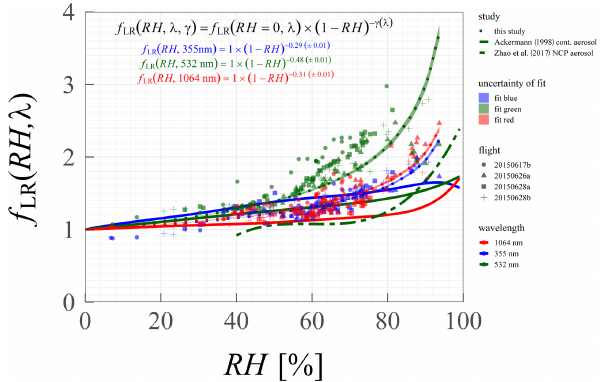
Figure 6. Mie-based RH-dependent LR( λ) enhancement factor f LR (RH, λ) calculated with the airborne in situ PNSD derived with ACTOS plotted for the three lidar wavelengths (dashed line). Sym- bols represent the investigated flights, colors are the considered wavelength, and the shaded area is around the standard error of the fit. In comparison, the estimates for the continental aerosol of Ack- ermann (1998) and Zhao et al. (2017) for the North China Plain (NCP) aerosol translated into the lidar ratio enhancement factor are displayed as solid and dotted-dashed